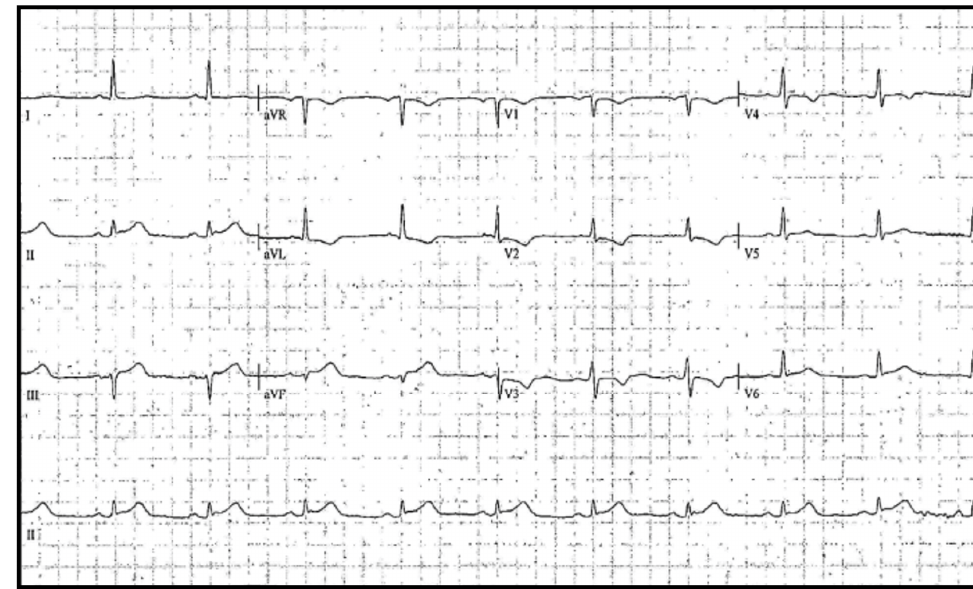
Figure 1. Electrocardiogram with sinus rhythm showing ST elevation in II, III, and aVF leads. Standard limb leads–I, II, III, augmented limb leads–aVR, aVL, and aVF, and precordial or chest leads– V1 to V6.